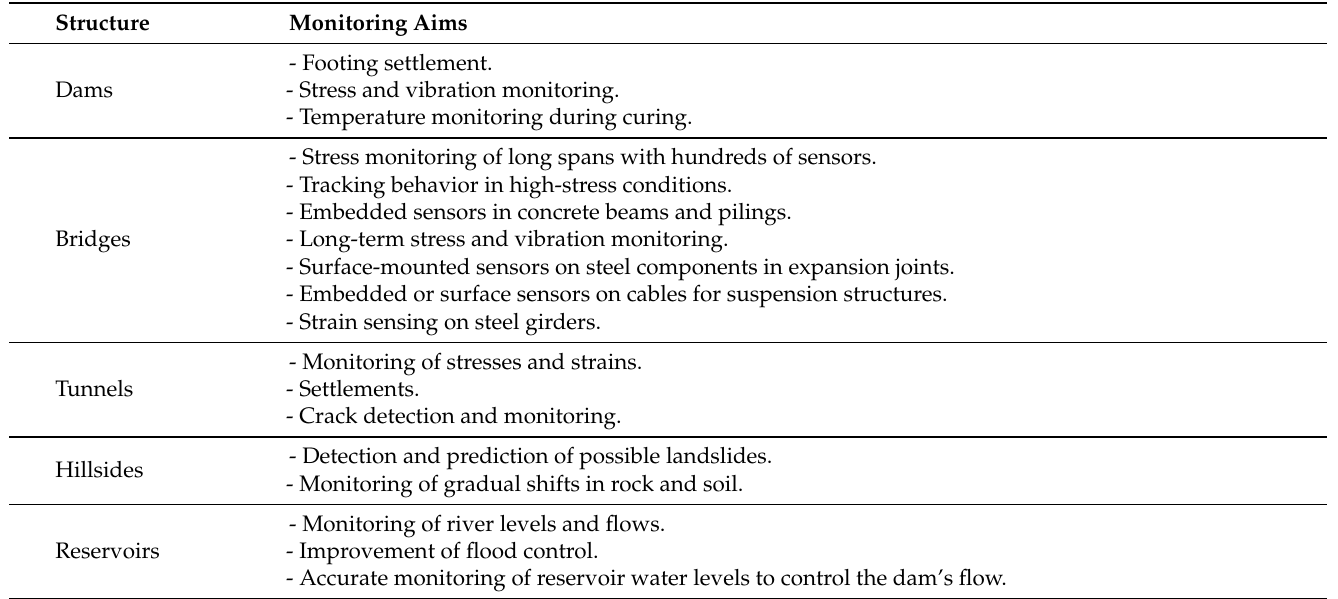
Table 2. Civil structure assessment using NDT and SHM techniques for various